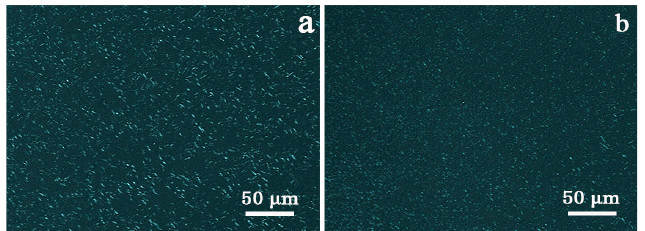
Figure 10. The POM micrographs for iPP-3 ( a ) and iPP/NA-21 ( b ) composites under isothermal crystallization at 135 °C for 5 min.